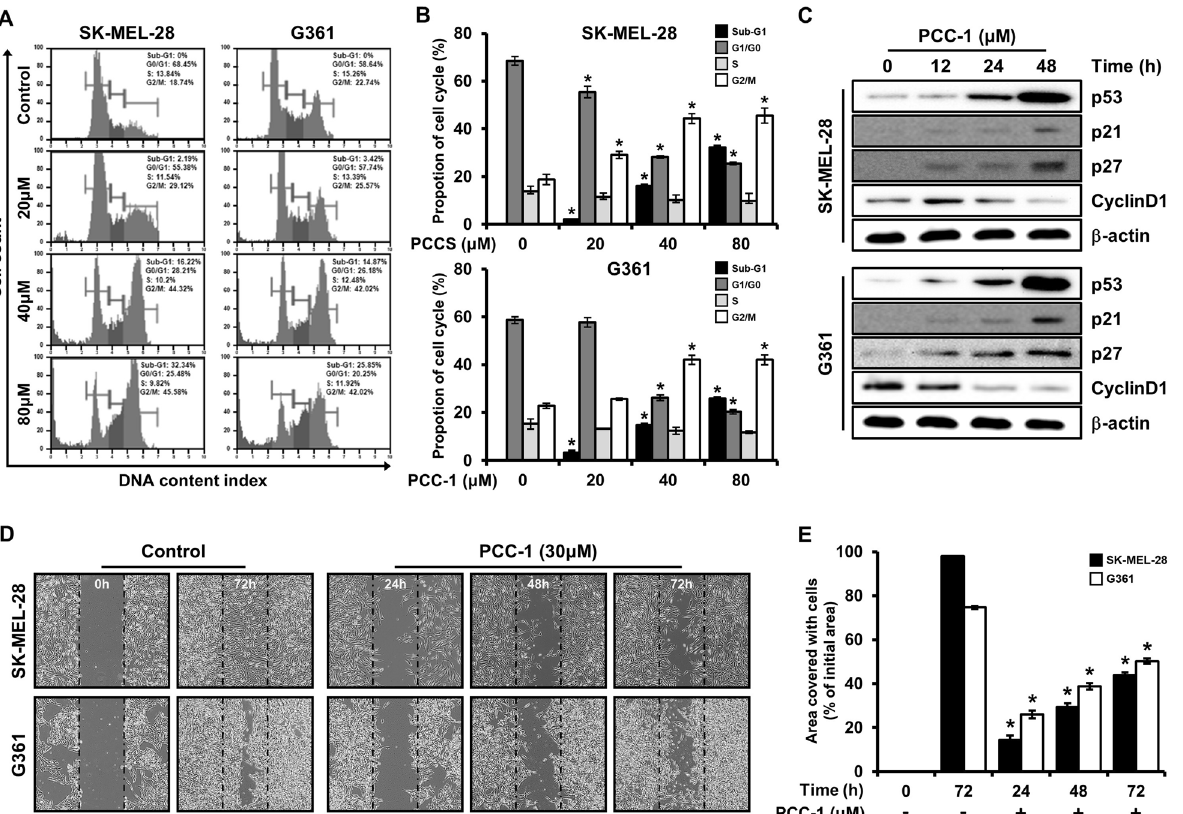
Figure 4. ( A ) SK-MEL-28 and G361 cells were treated with poecilocorisin-1 (PCC-1) (20, 40, and 80 μM) or untreated (control cells), and the cells were washed, fixed, stained with PI, and analyzed for DNA content by FACS analyzer. The percentage of apoptotic cells was measured using the Muse™ Cell Analyzer after propidium iodide (PI) staining. ( B ) The results of flow cytometry were quantified. Data represent the mean ± standard deviation (SD) (n = 3; *p < 0.05). ( C ) SK-MEL-28 and G361 cells were treated with PCC-1 (80 μM) and examined at 12, 24, and 48 h, and whole-cell extracts were prepared, separated on sodium dodecyl sulfate- polyacrylamide gel electrophoresis (SDS-PAGE), and subjected to western blotting using p53, p21, p27, and cyclin D1 antibodies. Actin was employed as a loading control. The results represent three independent experiments. Western blot analysis data complied with the digital image and integrity policy, and blots exposed from the same gel were used. ( D ) SK-MEL-28 and G361 cells were treated with PCC-1 (30 μM), and confluent cells were carefully scratched using sterile pipette tips and then re-cultured with or without PCC-1. At 24, 48, and 72 h, the cells were photographed under a microscope. ( E ) The results of the migration assay were quantified. Data represent the mean ± SD (n = 3; *p <